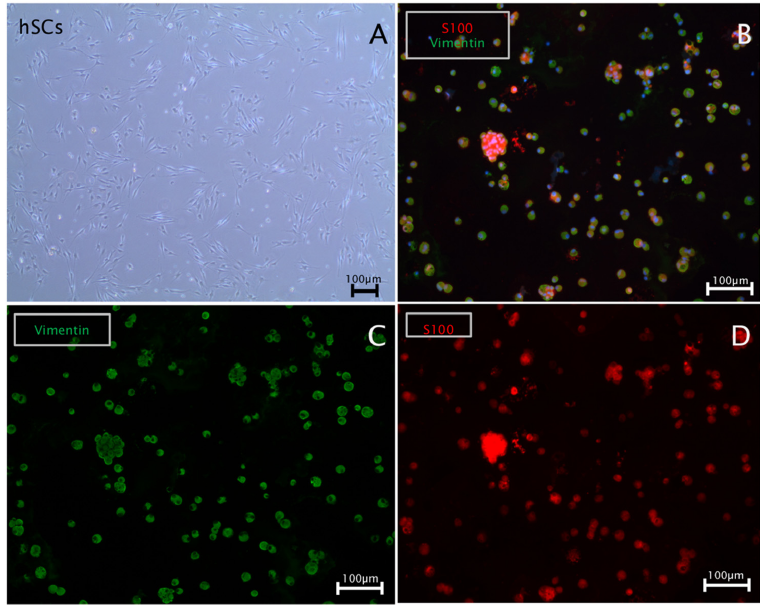
Figure 1. Characterization of human Schwann cell cultures: ( A ) a bright field image of a Schwann cell culture in vitro; ( B – D ) a representative immunostaining of human Schwann cell cytospins; ( B ) positive co-staining for S-100 (red), vimentin (green) and 4 ′ ,6-Diamidin-2-phenylindol (DAPI ) (blue); respective single channels for ( C ) vimentin (green) and ( D ) S-100 (red). ADSCs were cultured in a T75 flask for 3 days until 80% confluency was reached. Prior to seeding on the spider silk, cell aliquots were routinely cytospined to characterize cells using immunocytochemistry. ADSCs were stained with a specific marker panel, confirming positivity for reported ADSC surface molecules CD105, CD90, CD44 and negative staining for CD34 and CD45 as a control, illustrated in Figure 2.